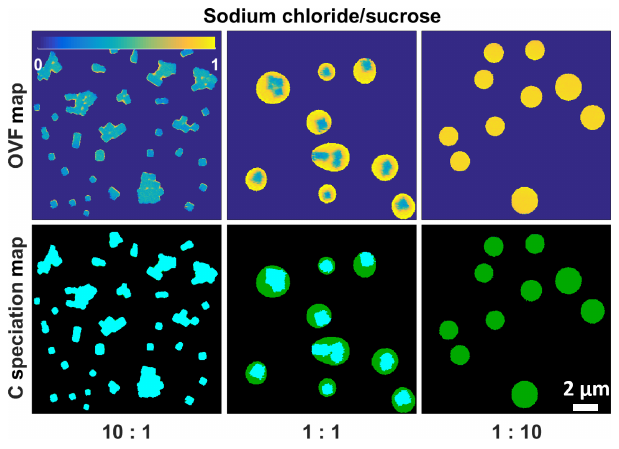
Figure 3. Representative organic volume fraction (OVF) maps and C-speciation maps for the sodium chloride / sucrose system. Sam- ples shown were collected from impactor stage C (0.5–0.25µm nominal size range). For the C-speciation maps, green represents organic-dominant regions and blue represents inorganic-dominant regions.